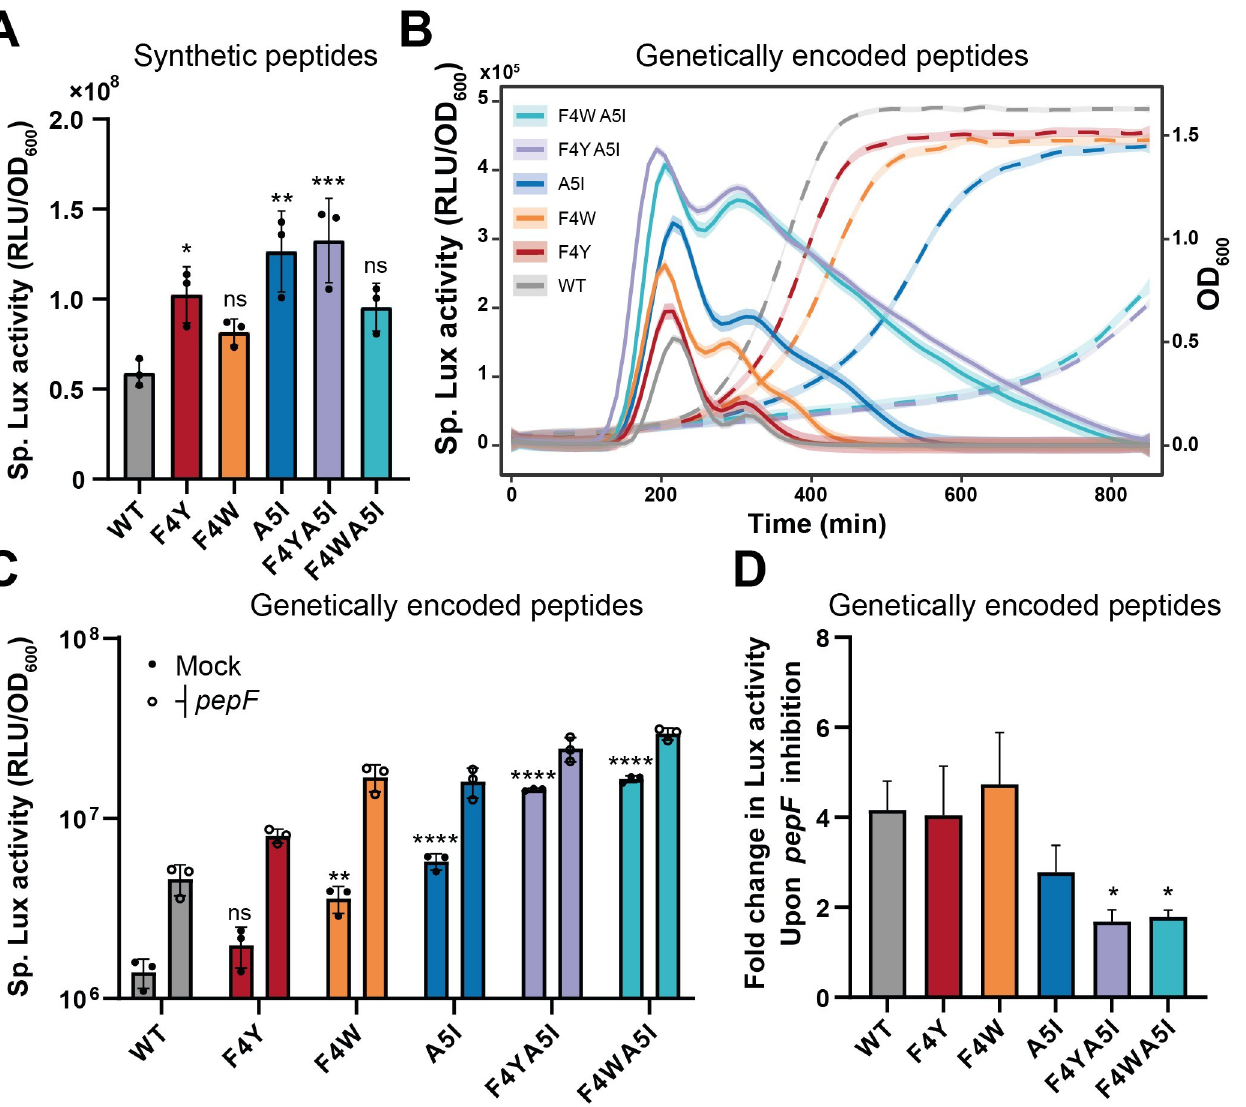
Fig 6. PepF-resistant peptides escape shut-off in vivo . (A) Impact on competence activation of the addition of the synthetic peptide variants. Data show specific luciferase activity (RLU/OD 600 ) measured with a P comS -luxAB reporter strain defective for the pheromone ( Δ comS ) supplemented with the synthetic peptide variants (5 nM). (B) and (C) Kinetics (OD 600 , dashed line; Sp. Lux activity, solid line) (panel B) and mean specific luciferase (panel C) of competence activation by genetically-encoded peptide variants (ComS, 24 aa). The comS native gene was mutated to produce the XIP variants into a xylose-inducible comR (P ) P reporter background together with the pepF dCas9 inhibition module. The comR native gene was deleted to avoid any toxic xyl2 -comR comX -luxAB spontaneous competence activation. Competence was induced by adding 0.5% of xylose. The bar represents the mean of biological triplicates (plain dots for competence activation and empty dots for competence activation together with pepF inhibition). (D) Fold change in specific luciferase activity for competence activation upon pepF inhibition for each peptide variant based on results presented in panel C. Bars denote standard deviations on specific luciferase activity or fold change computation. Dots denote biological replicates. In panel B, solid lines and dashed lines are representative of the mean of biological triplicates of specific luciferase activity and growth, respectively. Shaded lines depict standard deviation. One-way ANOVA with Dunett’s test was performed for each condition in comparison to WT (WT without pepF inhibition for panel C; � , P < 0.05; �� , P < 0.01; ��� , P < 0.001; ���� , P <